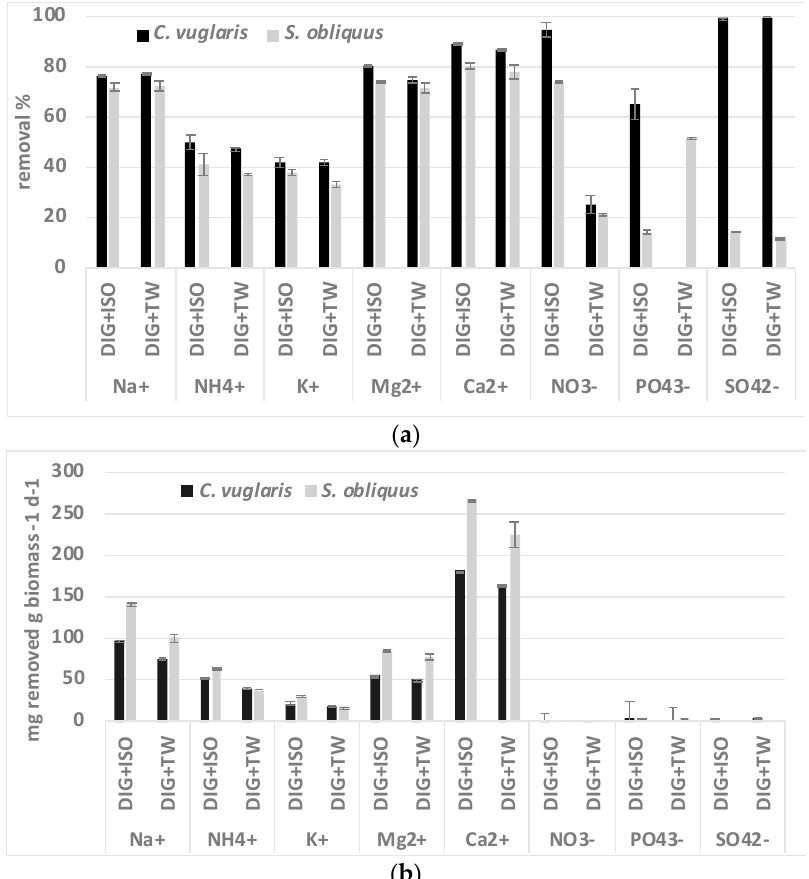
Figure 3. S. obliquus and C. vulgaris ( a ) nutrients removal percentage and ( b ) daily mg ions removal per g of biomass in OFMSW-WAS diluted 1:5 with ISO and in tap water conditions. ( n =